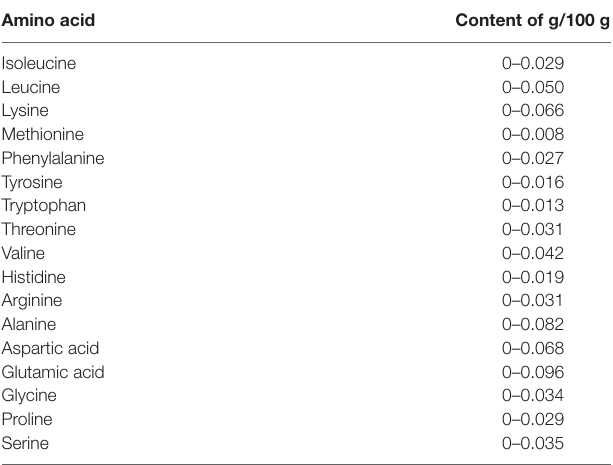
TABLE 2 | Amino acid composition in edible portion of mango fruit (United States Department of Agriculture, Agricultural Research Service,